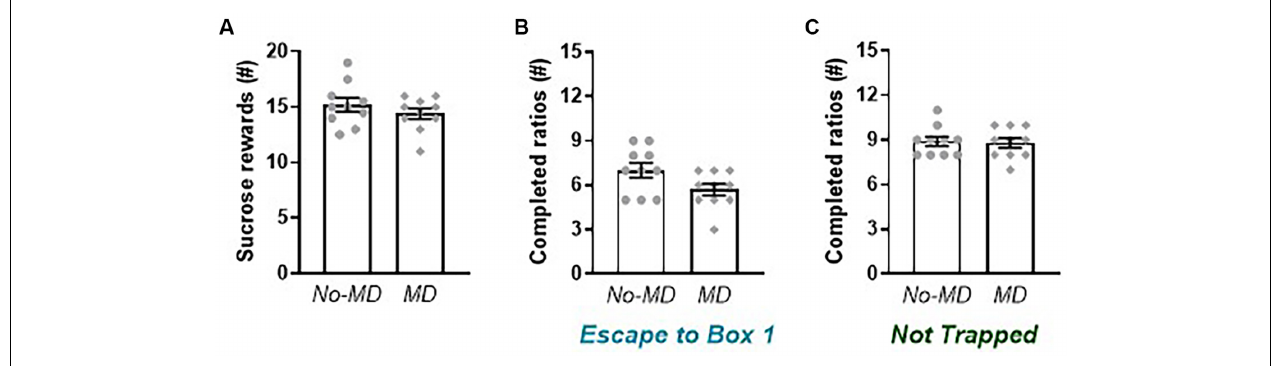
FIGURE 4 | Effect of maternal deprivation on sucrose reward and behavior in the liberation task. (A) The number of sucrose rewards earned in a progressive ratio design. (B) Motivation to liberate a cage mate (number of completed ratios) in the Escape to Box 1 configuration in an adapted progressive ratio design. (C) Motivation to open the doors in the Not Trapped configuration. Data represent individual data points and mean ± SEM, n = 10 per experimental